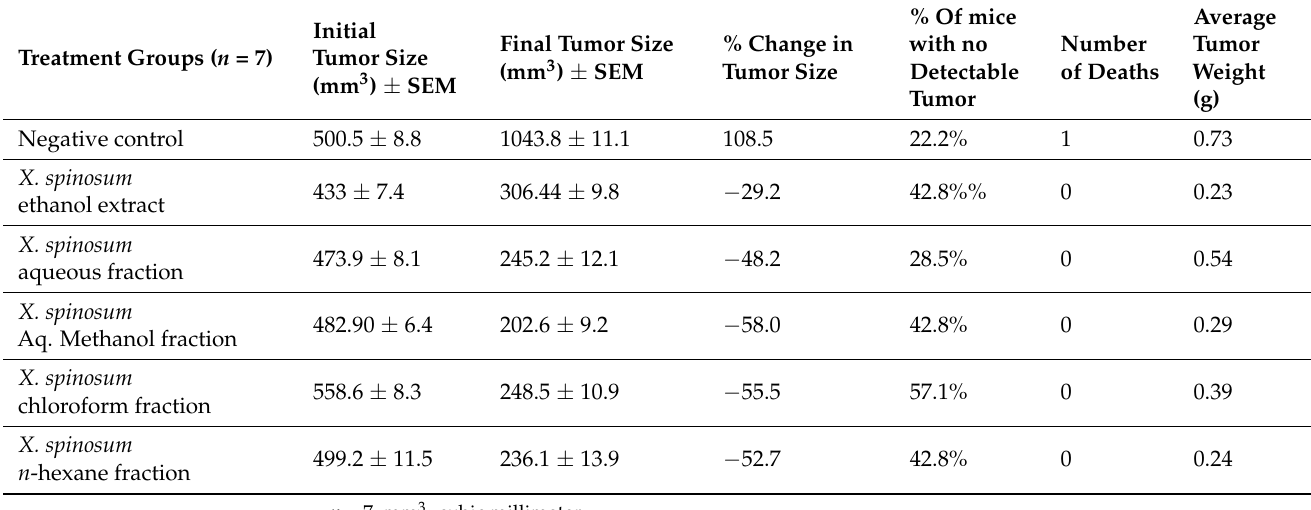
Table 9. Effects of X. spinosum extract and fractions on tumor size and cure percentage.